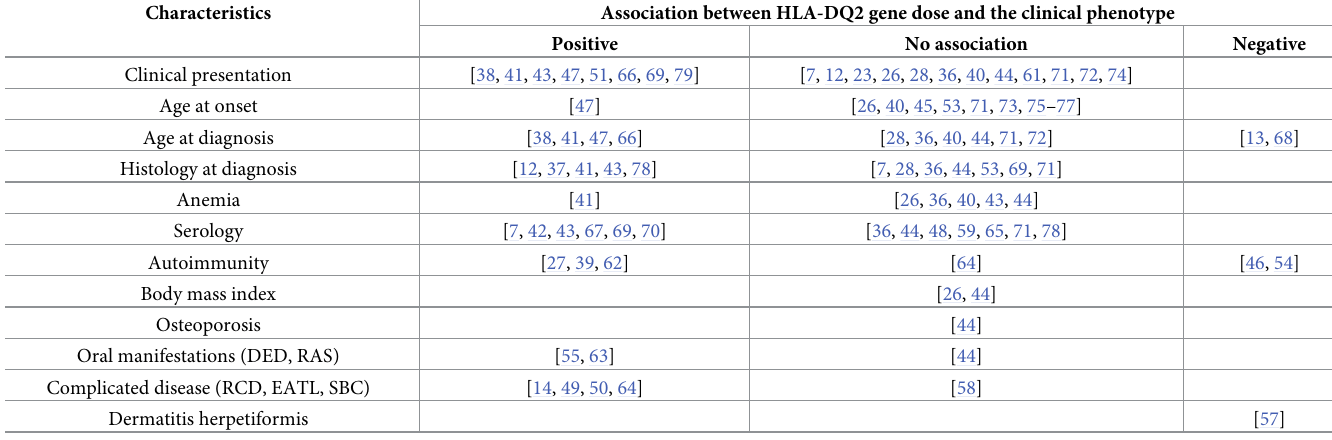
Table 3. Summary of studies reporting on gene dose effect.